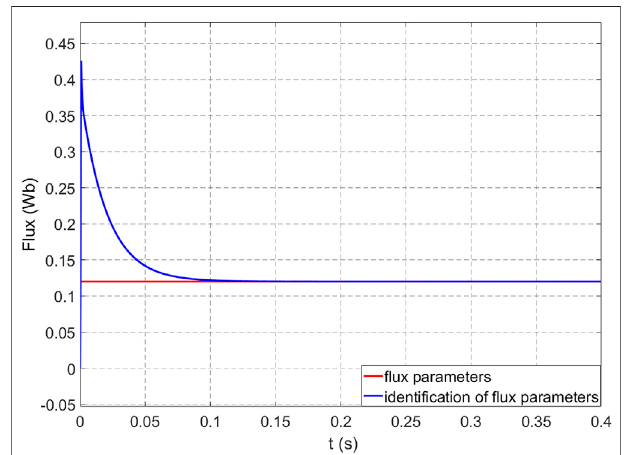
FIGURE 10 | Speed estimation with parameter identi fi cation.